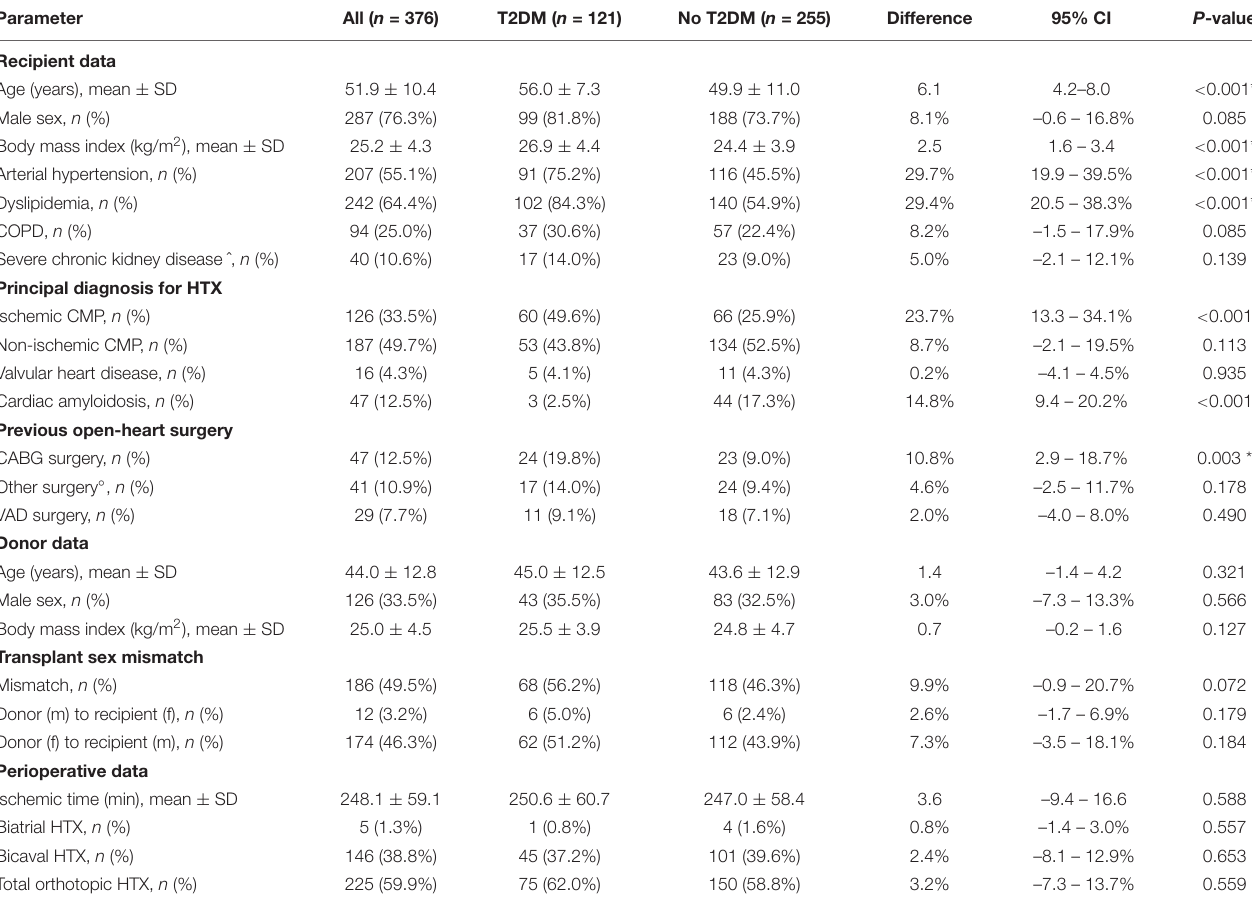
TABLE 1 | Baseline characteristics – stratified by T2DM at HTX.